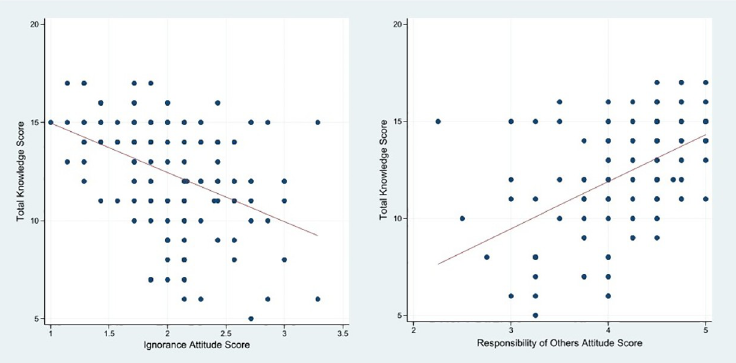
Fig 4. Correlation of total knowledge score with Ignorance and responsibility of others attitude